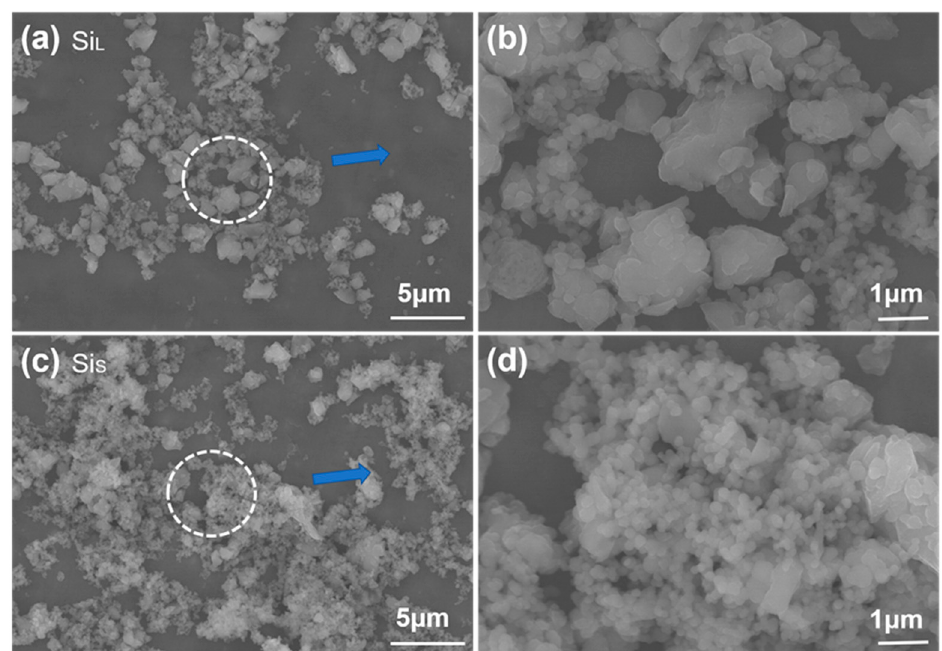
Figure 5. SEM images of ( a , b ) Si L and ( c , d ) Si S .